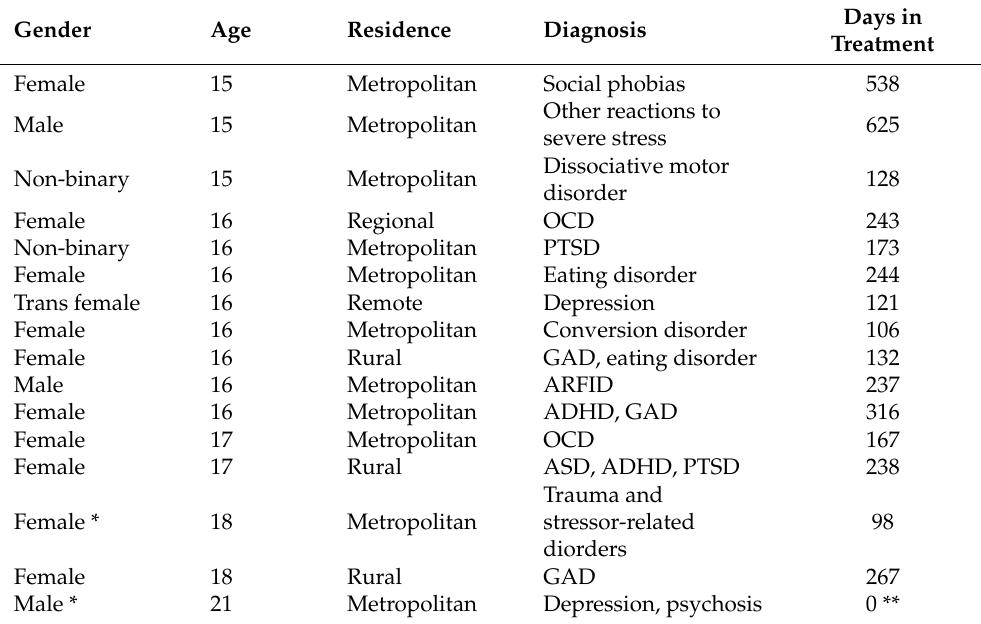
Table 1. Participant demographic